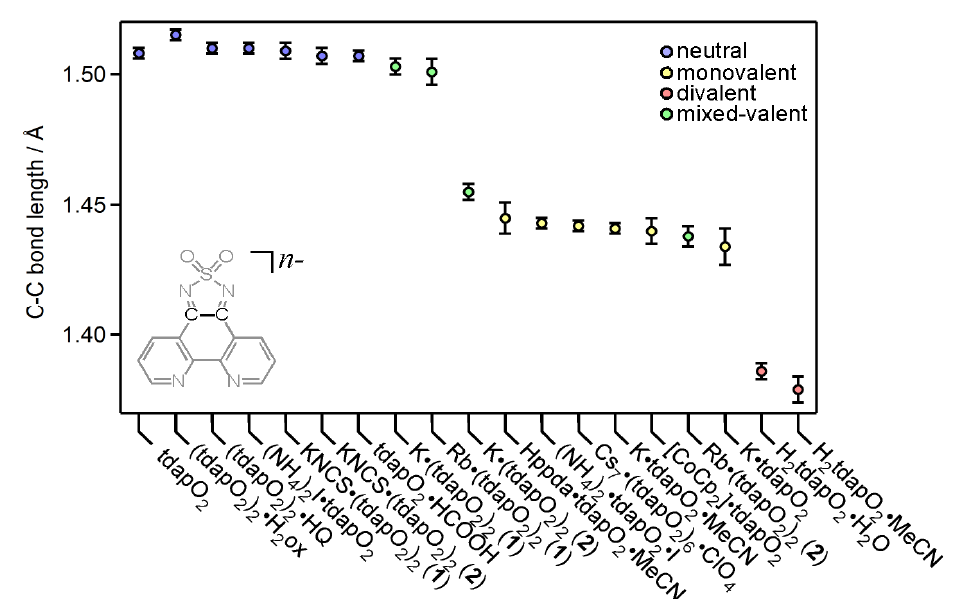
Figure 16. Selected C-C bond lengths of tdapO known. The colors of the circles represent the stoichiometrically determined valence of the . Error bars depict ±3 times the standard deviation of the bond lengths. tdapO 2